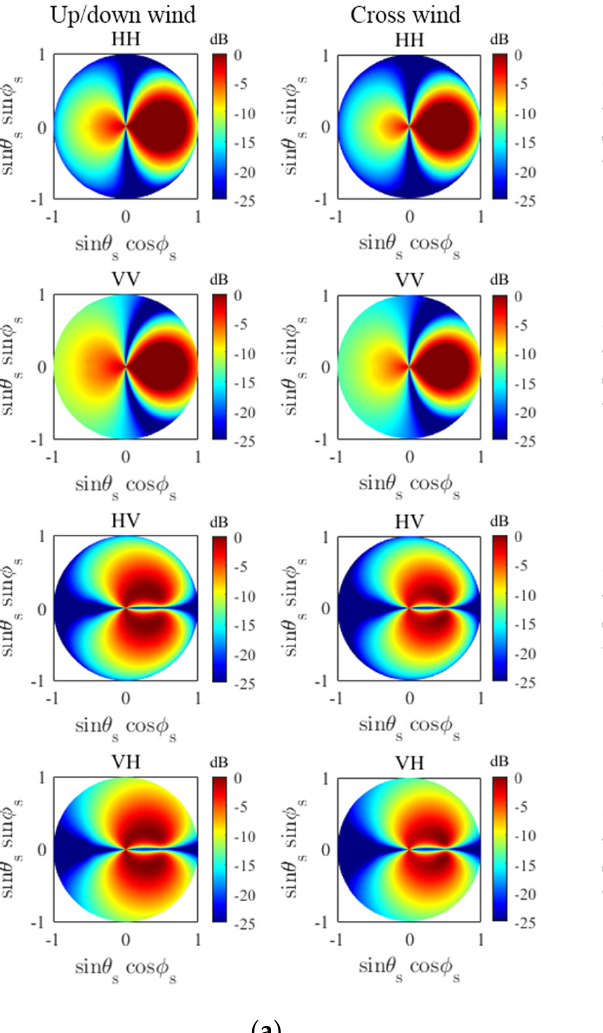
, σ 0 , σ 0 , σ 0 vv with θ i = 30 ◦ , φ i = 0 ◦ : ( a ) at 5.3 GHz hh hv vh